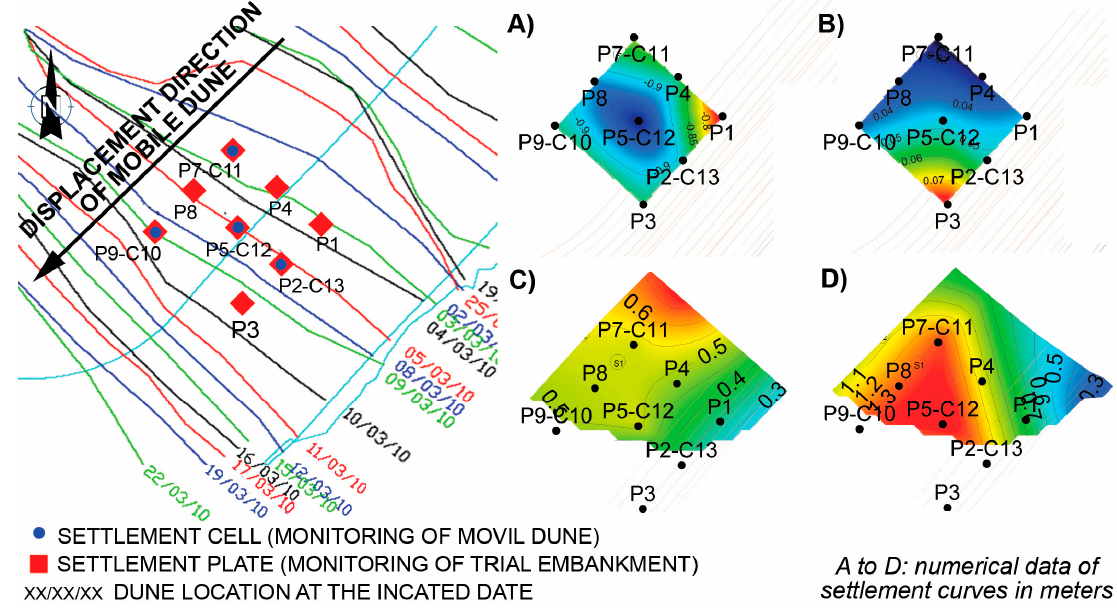
Figure 2. Maps of settlement distribution in the southeast area of the upper reservoir: ( A ) loading and stabilization stages of the trial embankment; ( B ) unloading stage of the trial embankment (rebound); ( C ) loading stage of the mobile dune; ( D ) accumulated settlement. (Mapping software: